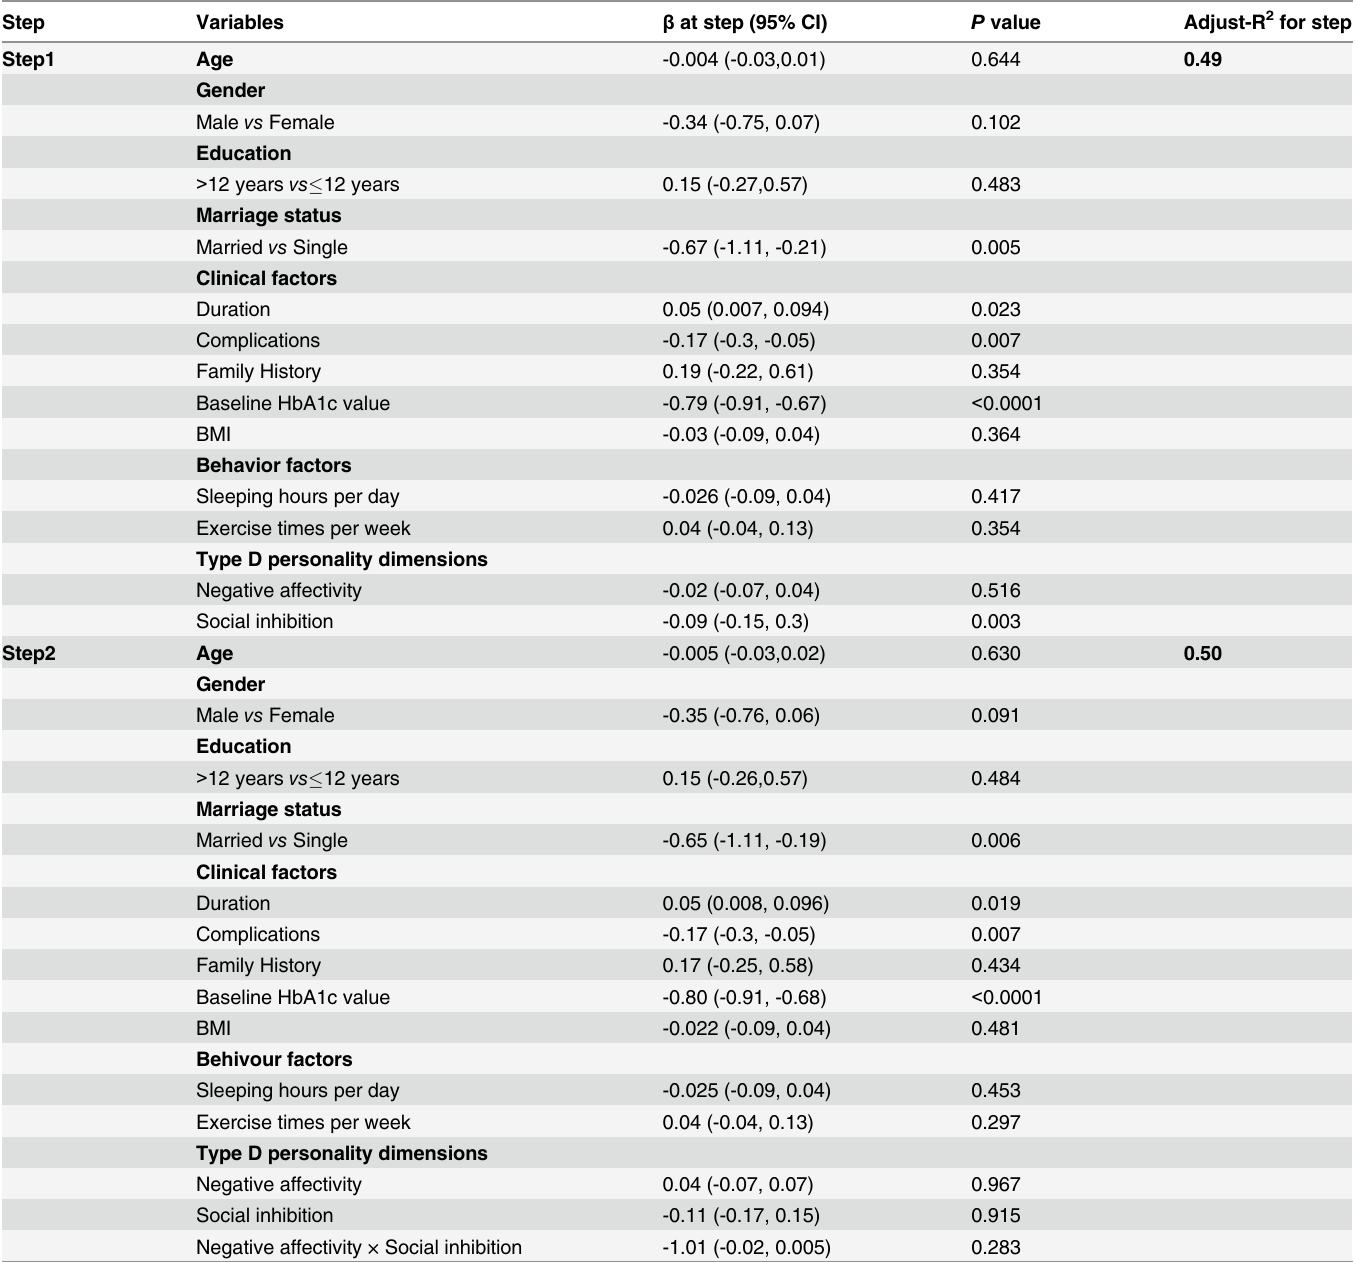
Table 5. Negative affectivity, social inhibition, and medication adherence 1